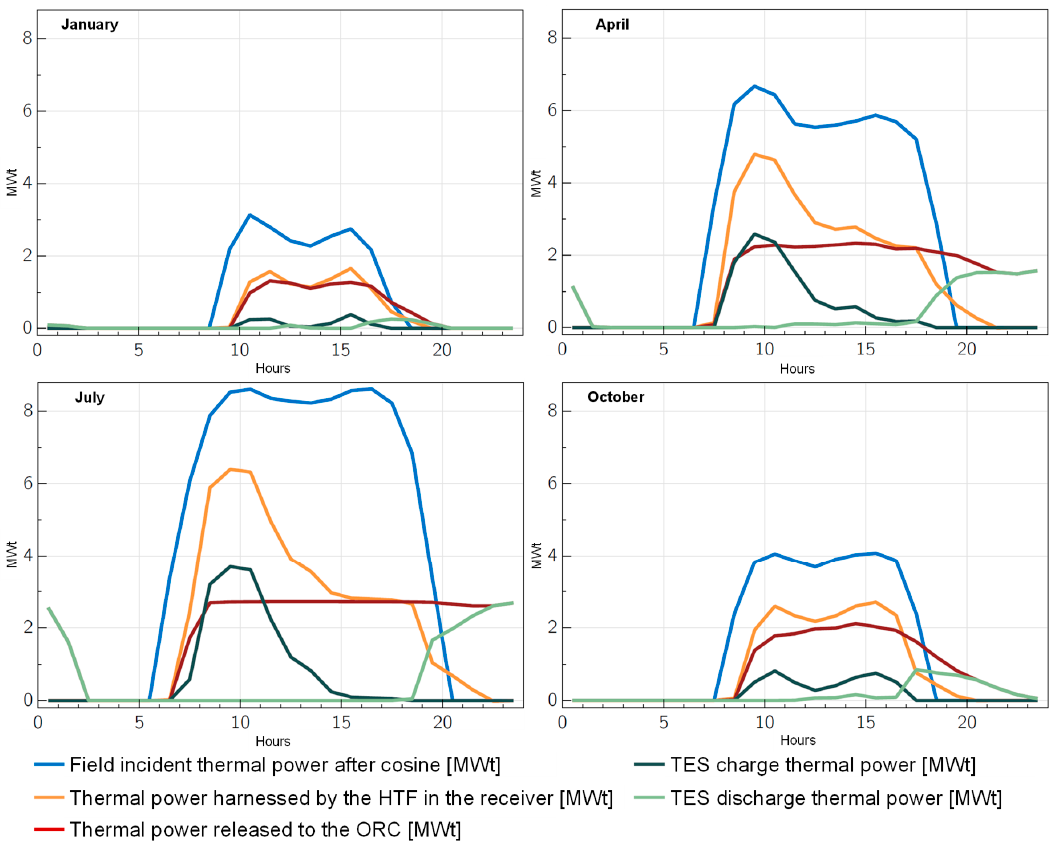
Figure 10. System A. Solar field hourly profiles obtained with System Advisor Model (SAM) [49] of indicated physical magnitudes for four selected months.